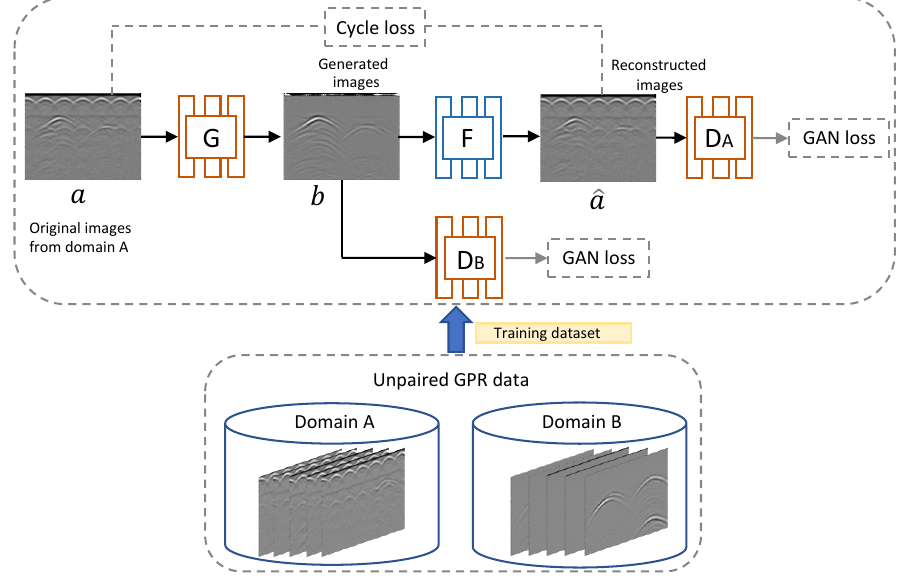
Figure 2. Architecture of the